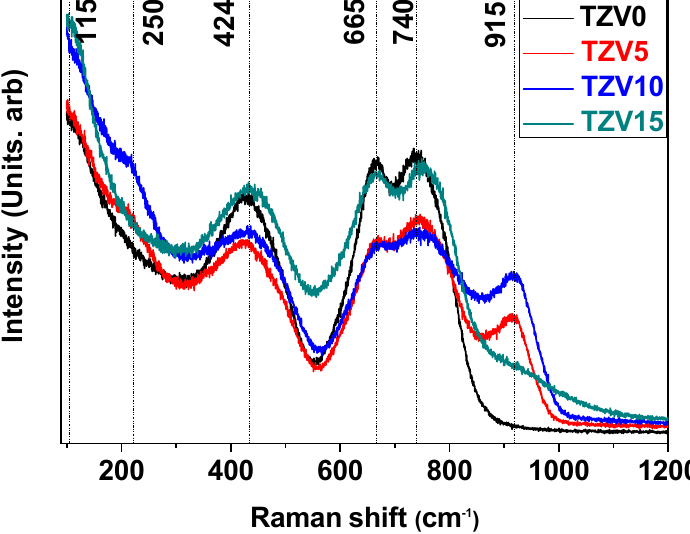
Figure 3. The Raman spectra of the TZV glasses.